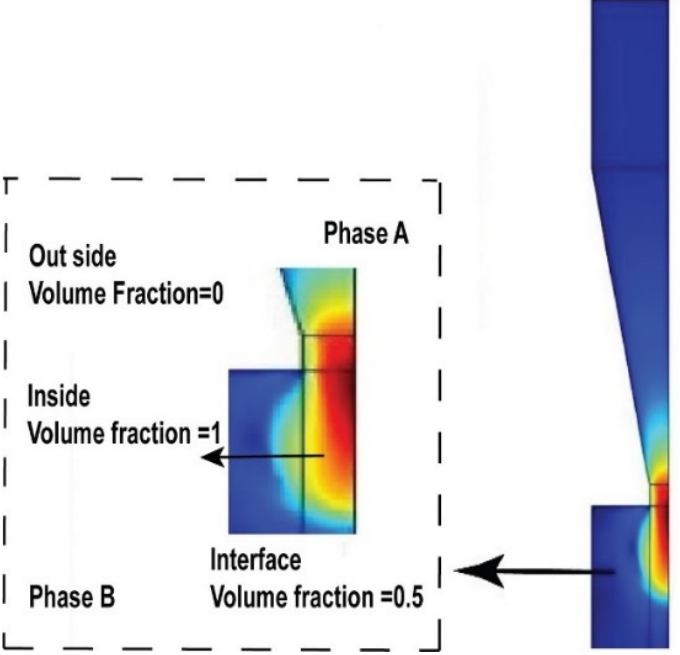
Figure 2. Presentation of different phases in the two-phase flow simulation by a level set method.